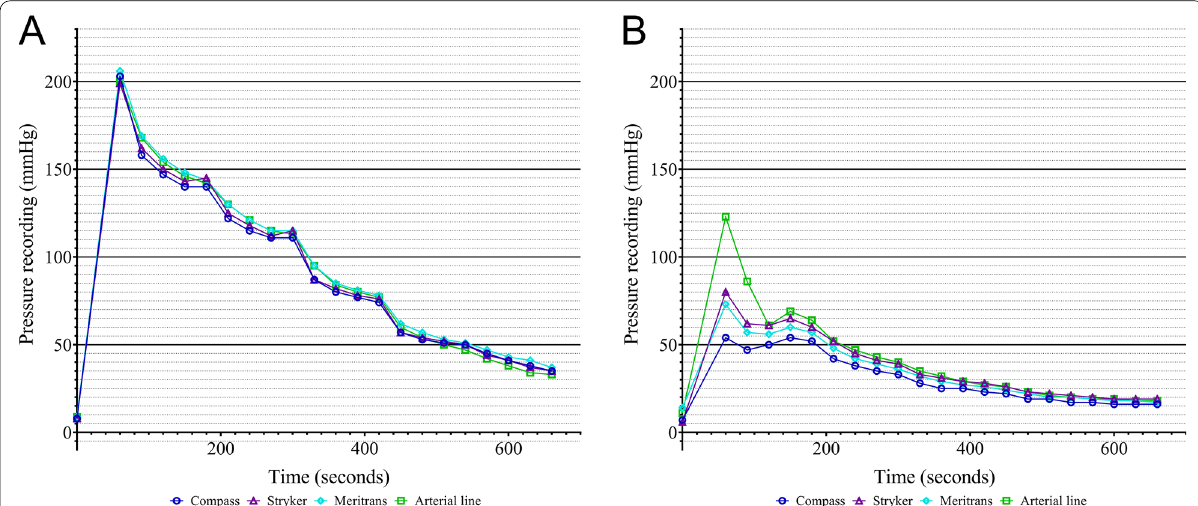
Fig. 4 Graphical illustration of the pressure recordings throughout the decay model for the four terminal devices (Compass manometer, the Stryker device, Meritrans transducer, and an arterial line) in combination with ( A ) a Venflon Pro Safety catheter (18 gauge) and ( B ) a Microlance straight